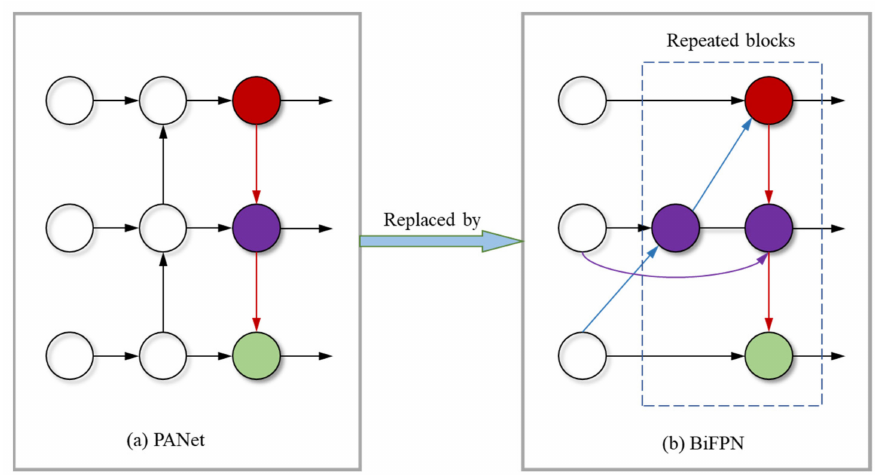
Figure 7. Using BiFPN instead of PANet to improve the feature fusion network. The colored circles represent features at different scales. ( a ) PANet adopts bottom-up and top-down paths to fuse multi- scale features; ( b ) BiFPN uses the strategy of bottom-up and top-down bidirectional feature fusion.